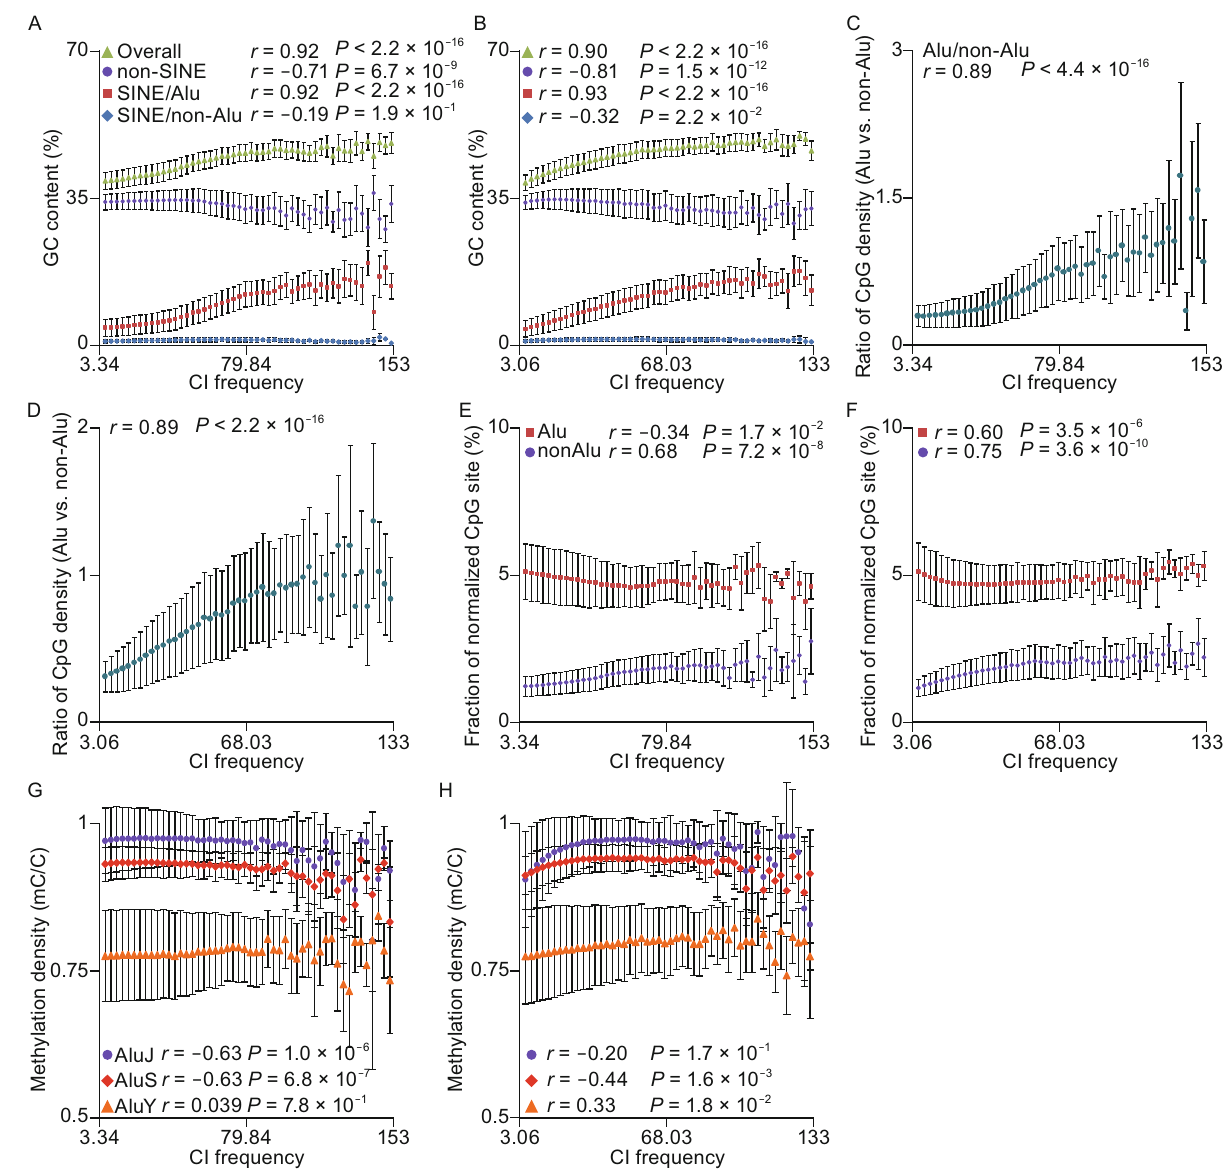
Figure 3. The GC content, CpG content, and methylation rate of bin-pairs and SINEs. (A and B) GC content of genome background, Alu elements regions, SINE/non- Alu regions (other transposable elements in SINE type) and non-SINE regions (regions that aren ’ t covered by SINEs) in each frequency bin (A: hESC; B: IMR90 fi broblasts). (C and D) The ratio of CpG density of Alu regions and genome non- Alu regions ( Alu regions + SINE/non- Alu regions + non-SINE regions) increased as the increasing of CI frequencies. (C: hESC; D: IMR90 fi broblasts). (E and F) The fraction of normalized CpG sites in Alu regions and non- Alu regions ( Alu regions + SINE/non- Alu regions + non-SINE regions) (E: hESC; F: IMR90 fi broblasts). (G and H) Methylation density (the ratio of the methylated cytosine in CpG site) of three Alu subfamilies, Alu J, Alu S, and Alu Y (G: hESC; H: IMR90 fi blue diamond) and IMR90 ( r = − 0.32, P = 0.022, blue dia- frequencies in hESC ( r = 0.92, P < 2.2 × 10 − 16 , red square) mond), respectively (Fig. 3A and 3B). On the other hand, GC and IMR90 ( r = 0.93, P < 2.2 × 10 − 16 , red square), whereas contents derived from Alu s, on average, are generally higher those contributed by SINE/non- Alu s are not or negatively than those from SINE/non- Alu s, suggesting that large correlated with CI frequencies in hESC ( r = − 0.19, P = 0.19,